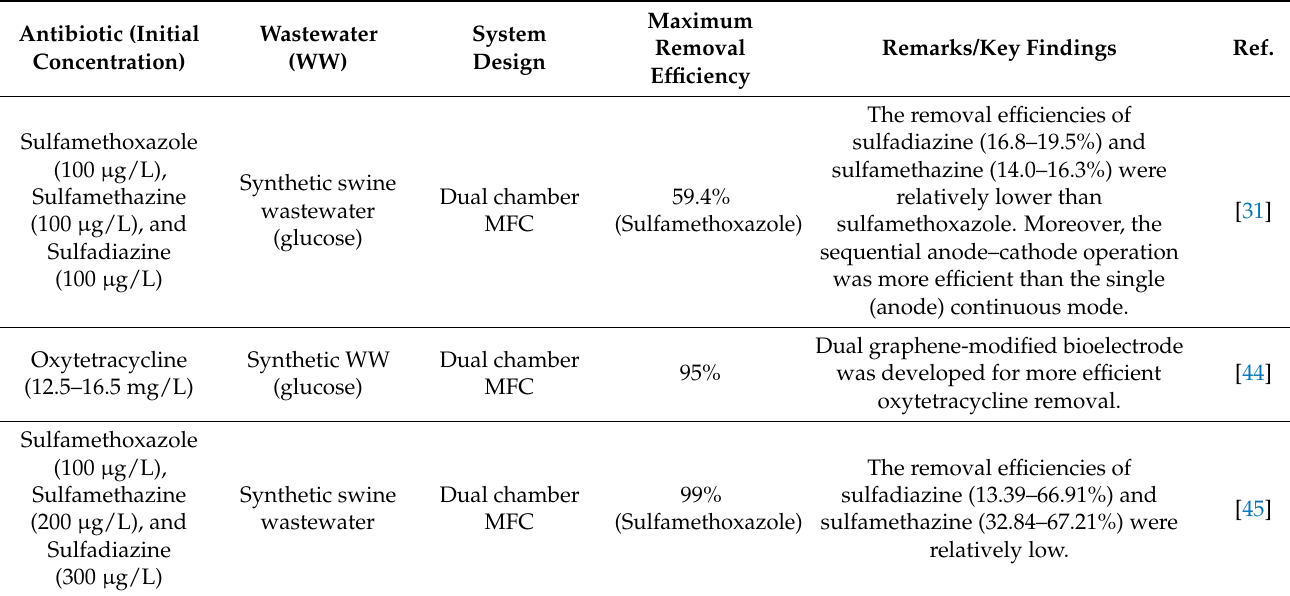
Table 1. Summary of studies using microbial electrochemical systems as a stand-alone process for antibiotics removal from